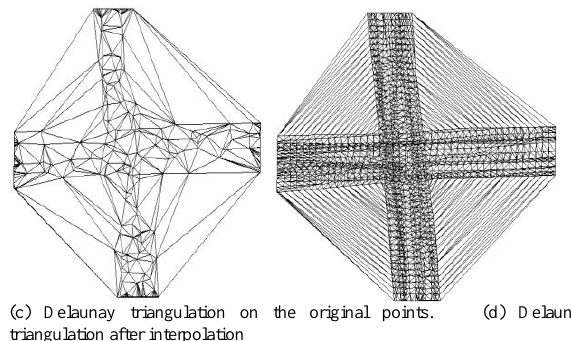
Figure 1. Delaunay triangulation on the trajectory points